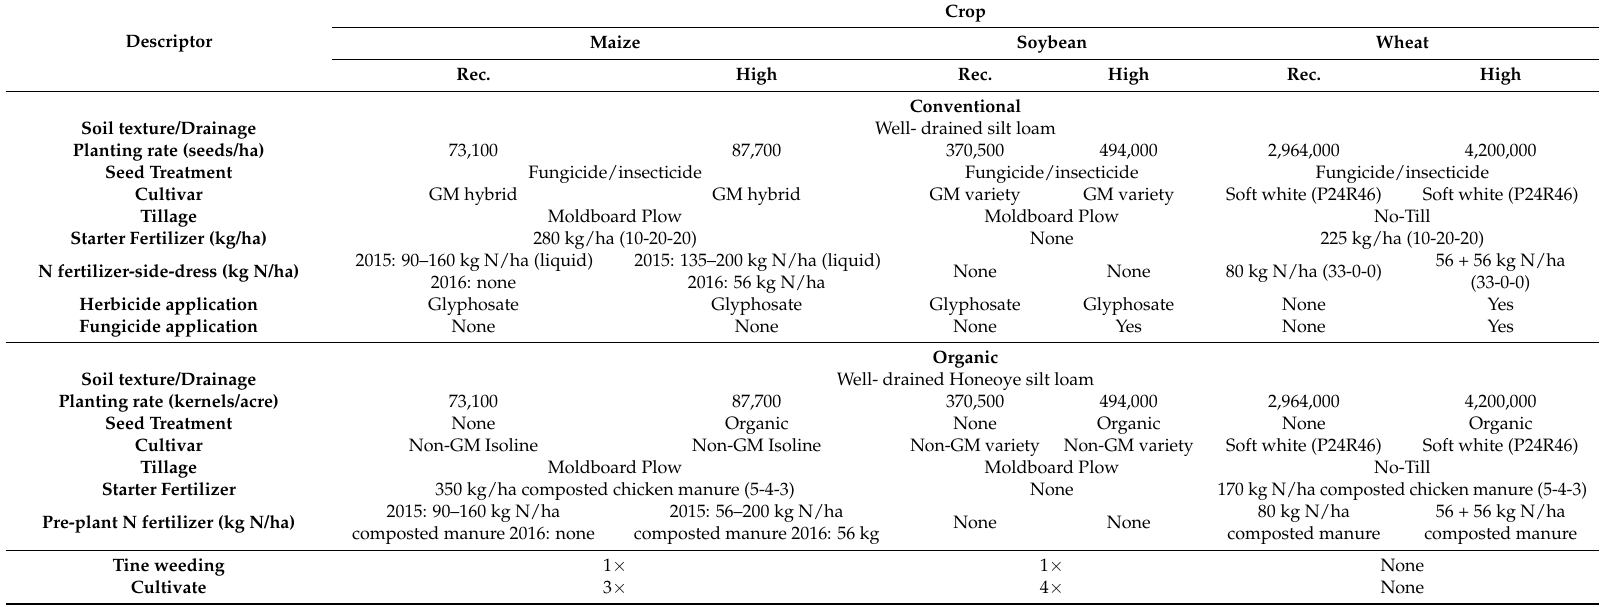
Table 1. Soil texture/drainage, planting rate, hybrid/cultivar, tillage, starter and N fertilizer practices, and weed control practices for maize, soybean, and wheat in conventional and organic cropping systems with two management treatments (recommended and high input) at a Cornell Research Farm near in central NY in 2015 and